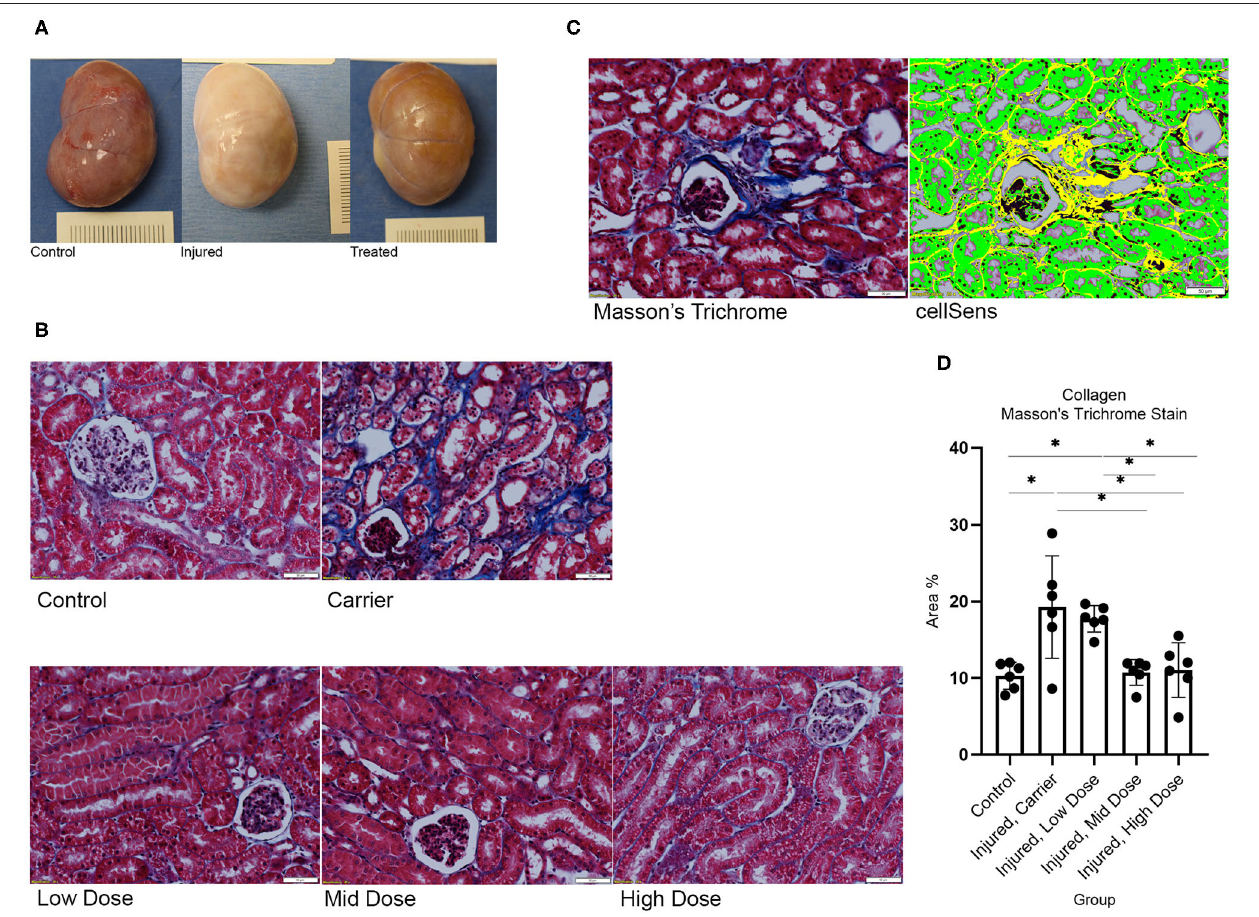
FIGURE 3 | (A) Gross necropsy of left kidney for Control, I/R injured, and CXCL12 treated. I/R resulted in renal fibrosis (white discoloration) that was restored with treatment. (B) Histology of left kidney CMJ stained with Masson’s Trichrome under 200 × magnification for each study group. I/R (Carrier) increased collagen accumulation, stained blue. CXCL12 Treatment restored I/R-induced changes in collagen in a dose-dependent manner. (C) Masson’s Trichrome stain image and cellSens Imaging Software-generated image used to calculate Area % of collagen (yellow). (D) One-way ANOVA for Area % of positive staining for collagen for each group on Masson’s Trichrome stain showed a significant group effect, F (4,25) = 8.408, p < 0.01. n = 6/group. Values are individual dot plot and mean ± SD. * p < 0.05.